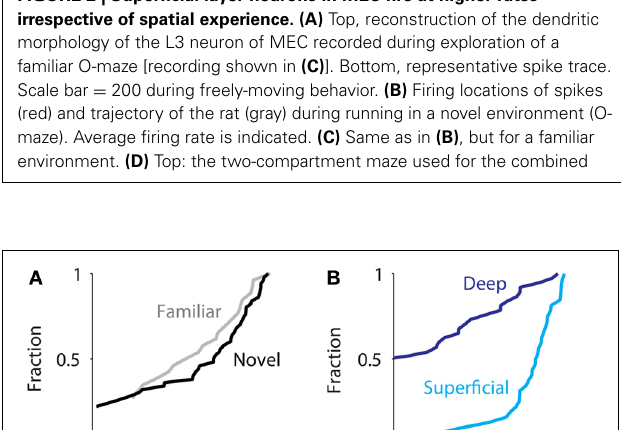
FIGURE 3 | Layer is a strong determinant of average firing rate in MEC. (A) Cumulative distribution of average firing rates for all juxtacellularly recorded neurons recorded in novel (black, n = 57) and familiar environments (gray, n = 31). The two distributions are not statistically different [median for novel 0.54 ( n = 57), familiar 0.17 ( n = 31); p = 0 . 4, Wilcoxon rank-sum test]. (B) Cumulative distribution of average firing rates for all juxtacellularly recorded neurons recorded in superficial (light blue, n = 33) vs. deep layers (dark blue, n = 37), irrespective of spatial experience. The two distributions are statistically different (median for superficial 2.3, deep 0.0, p = 1 . 4 10 − 7 , Wilcoxon rank-sum test).